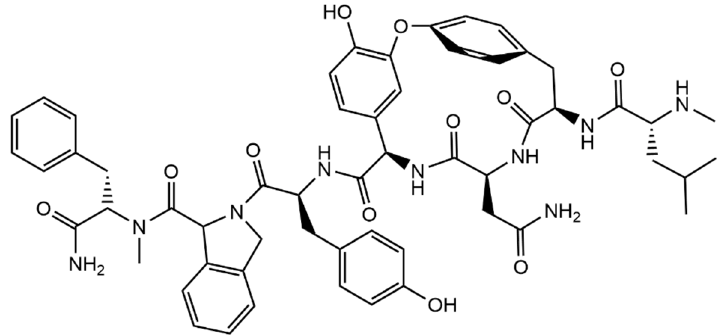
Figure 27. Structure of the peptidyl vancomycin derivative receptor, VD1 [161].